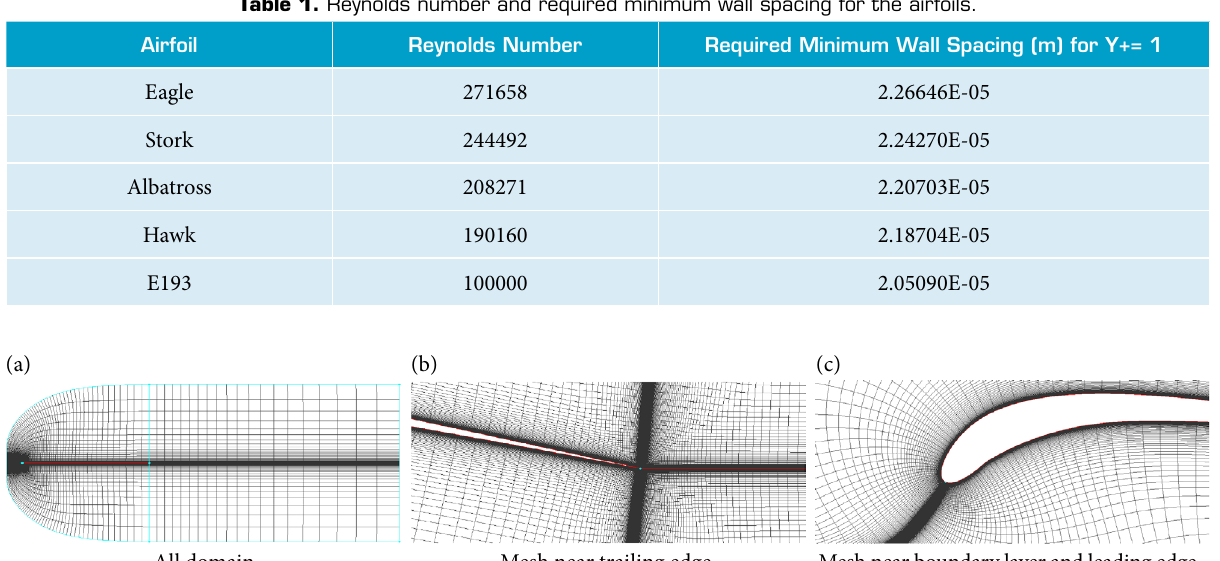
Figure 2. Mesh around eagle’s